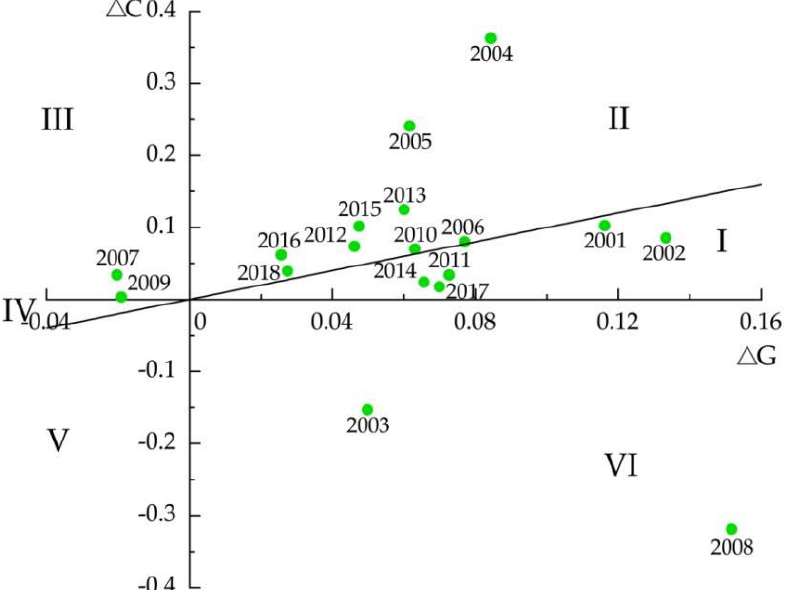
Figure 4. Decoupling distribution of agriculture. Note: I, II, III, IV, V, and VI represent weak decoupling, expansive coupling, strong coupling, weak coupling, recessive decoupling, and strong decoupling, respectively.